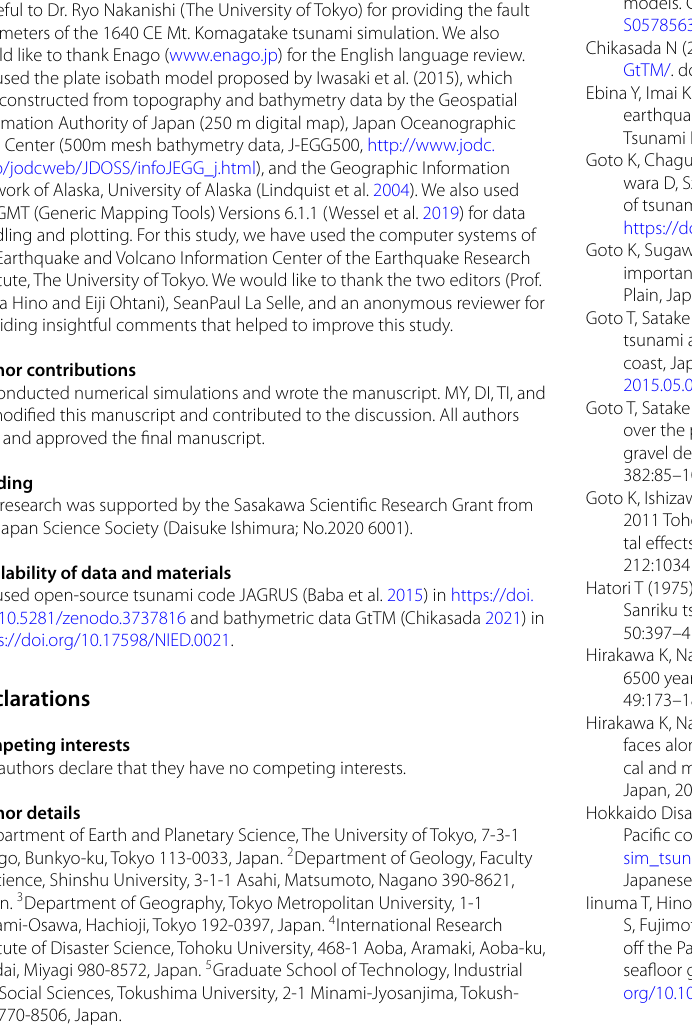
Mw 8.62, g U2 model with Mw 8.62. The red circle and black triangle show the tsunami and non-tsunami deposit sites, respectively, by Nakanishi and Okamura (2019). The red circle in f represents the most inland “sand layer” site in “Line KJH” investigated by Nakanishi and Okamura (2019) Additional file 6 : Fig. S5 Computed results using the S2 model at Oikamanai, Harashinai, and Masaki. The red circles show tsunami deposit locations a found by Nanayama et al. (2002) in Oikamanai pond and b and c found by Takada et al. (2016) in Harashinai and Masaki, respectively. The solid contour shows the topography, and the dotted contour shows the bathymetry (less than 0 m). The contour intervals are 2 m. Additional file 7 : Fig. S6 Computed results using the Hidaka (base) model at Oikamanai, Harashinai, and Masaki. The red circles show the tsunami deposit locations a found by Nanayama et al. (2002) in the Oika- manai pond and b , c those found by Takada et al. (2016) in Harashinai and Masaki. The solid contour denotes the topography. The dotted contour represents the bathymetry of fewer than 0 m. The contour intervals are 2